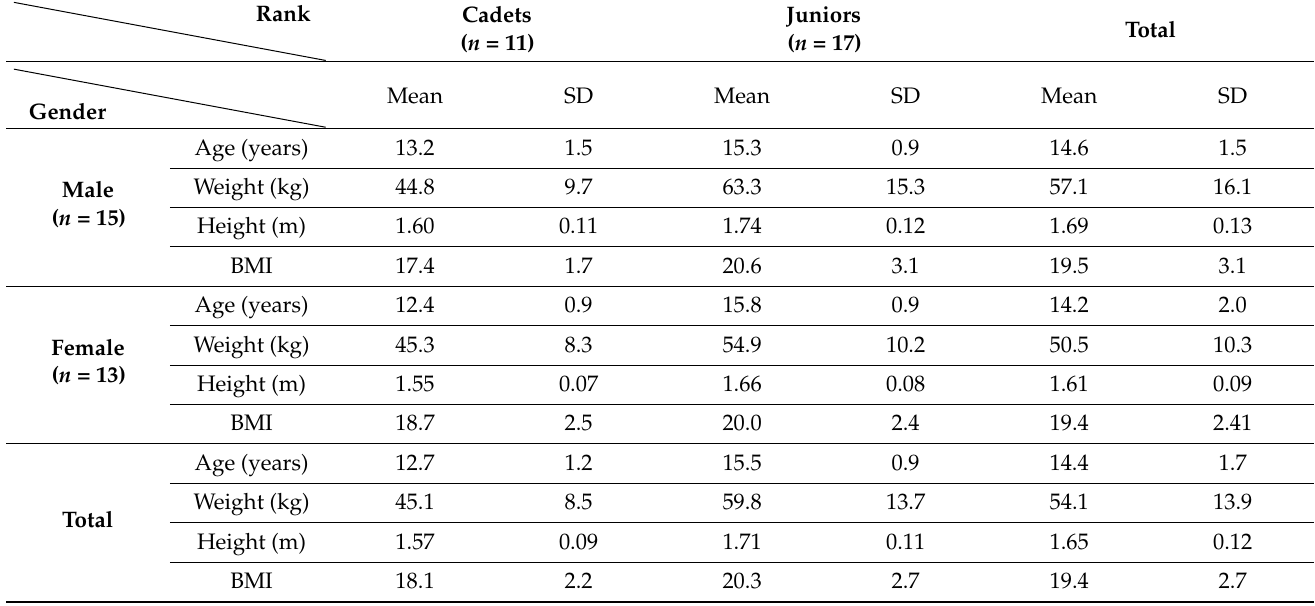
Table 1. Sample characteristics (N =